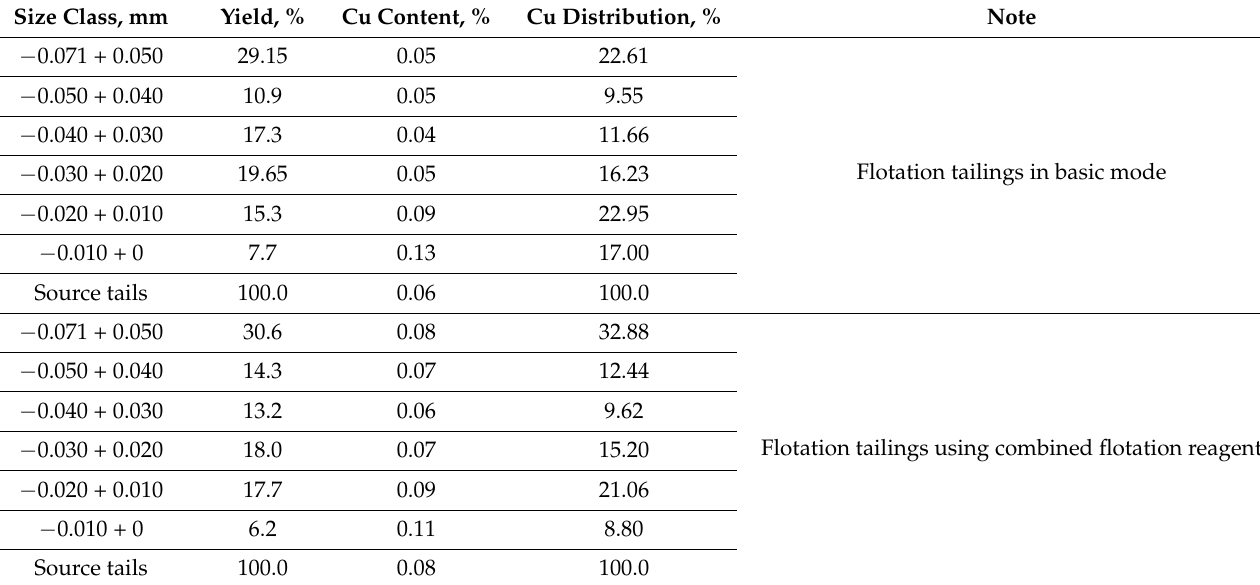
Table 4. Results of dispersion analysis of flotation